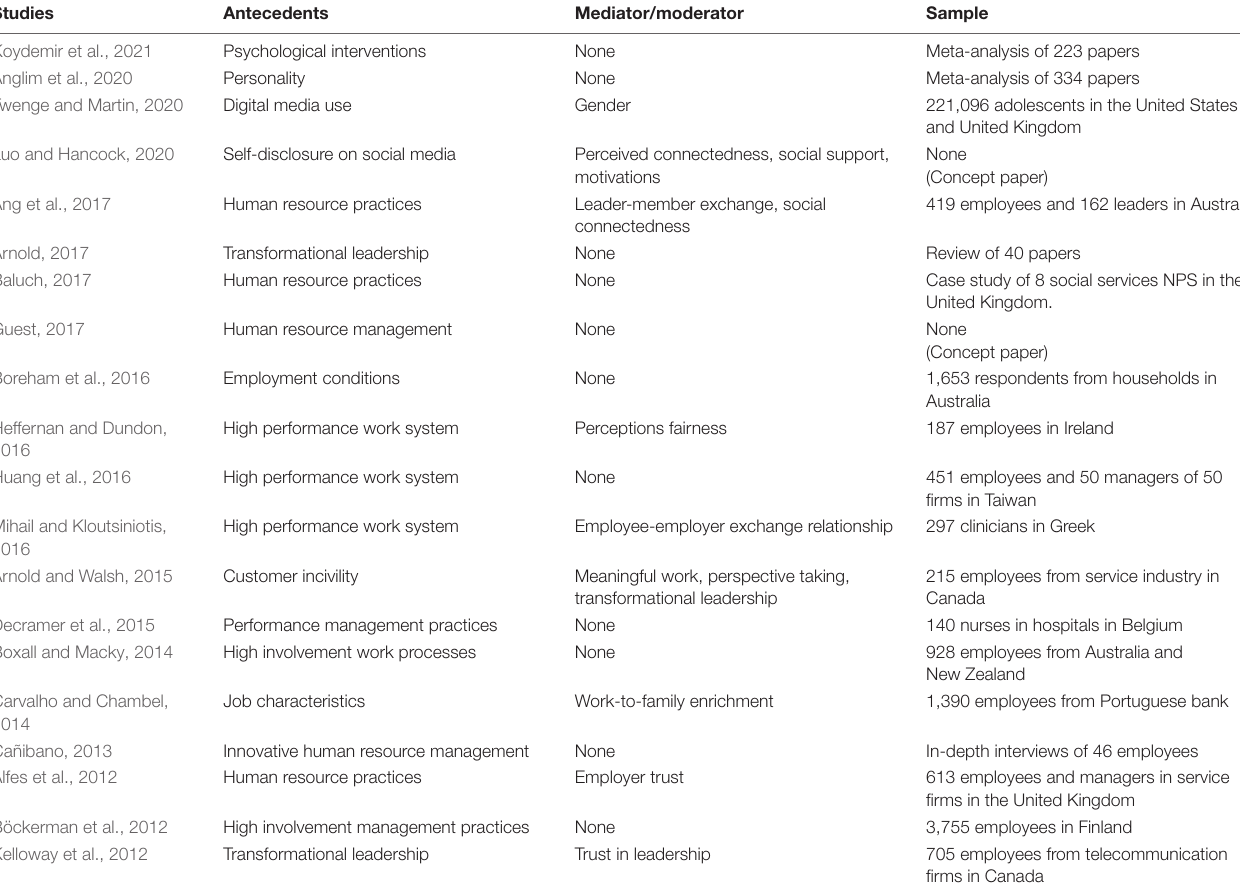
TABLE 1 | Literature review of antecedents of psychological